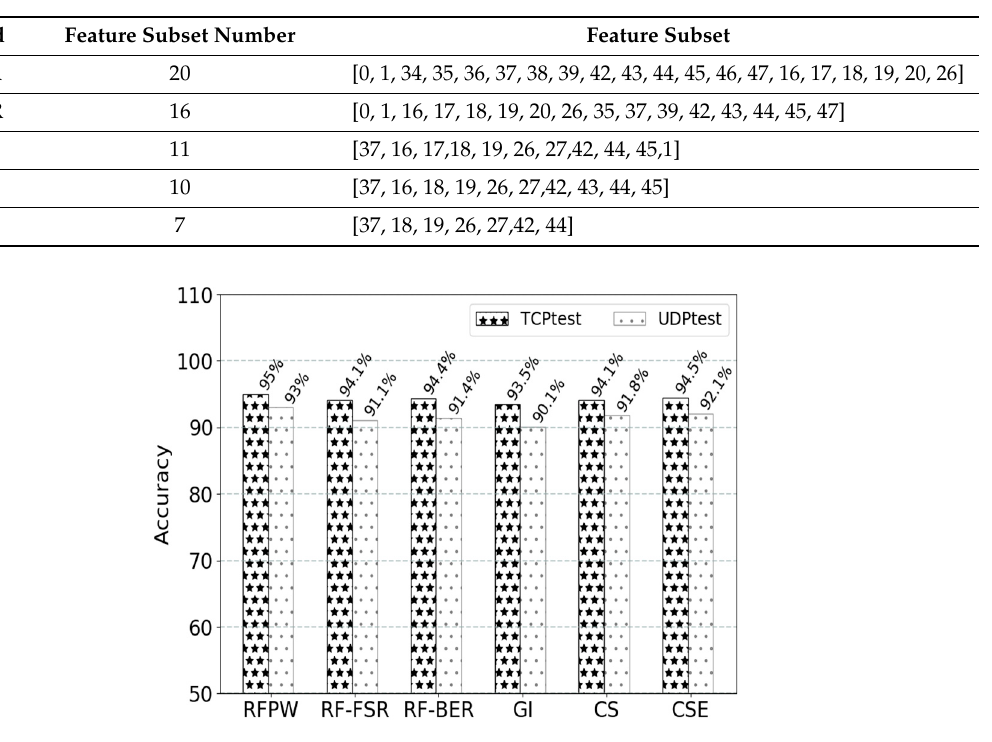
Figure 13. TCPtest and UDPtest represent the accuracy of the test set in the TCP flow and UDP flow data, respectively.